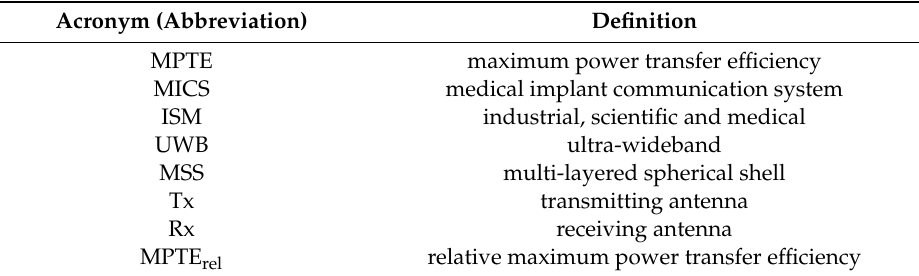
A list of acronyms and abbreviations is given in Table A1 for the convenience of the readers. Table A1. List of acronyms and abbreviations.